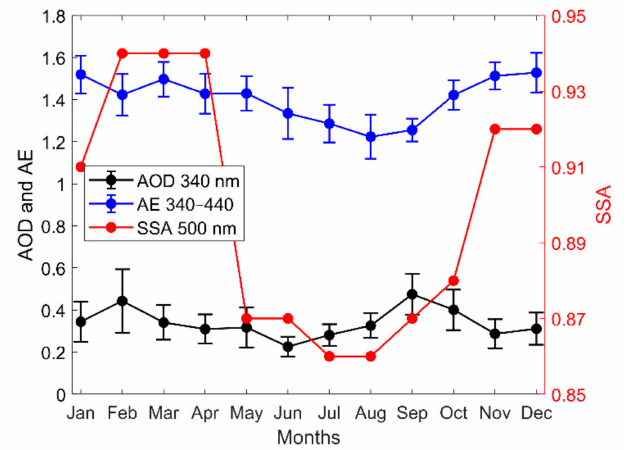
Figure 2. Monthly means and standard deviations of aerosol properties for 2011 to 2018 from sun photometer observations at the CSIR: Aerosol optical depth (AOD) at 340 nm (black) and Ångström Exponent (AE) (blue) in the 340–440 nm spectral band as well as monthly mean single scattering albedo (SSA) at 550 nm (red) from the MACv2 aerosol